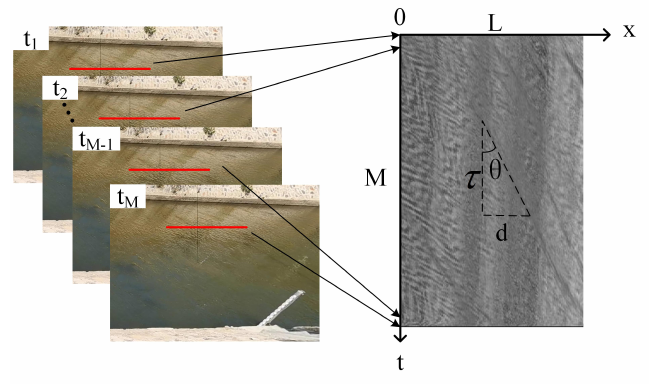
Figure 1. Generation of space-time